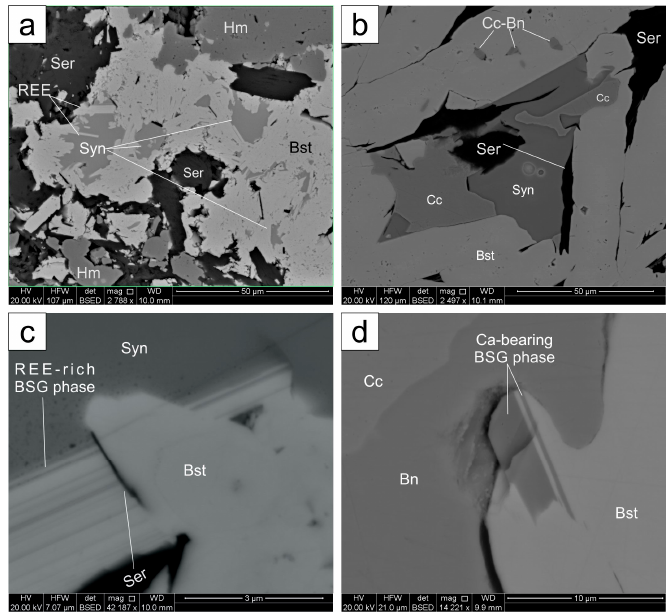
Figure 6. BSE images showing petrographic aspects of synchysite: ( a ) Synchysite (Syn) as patchy, interstitial filling between aggregates of bladed bastnäsite (Bst) (Sample RX6714). Hm-hematite, Ser- sericite; ( b ) Synchysite intergrown with chalcocite (Cc) and sericite locally replacing bastnäsite (sample RX6726). Bn-bornite; ( c ) Synchysite with intergrowths of a second REE-bearing phase (REE-rich BSG phase) along long axis. Sericite and bastnäsite crosscut both synchysite and REE intergrowths (sample RX6714); ( d ) Polysynthetic twinning between bright and dark phases. (Sample